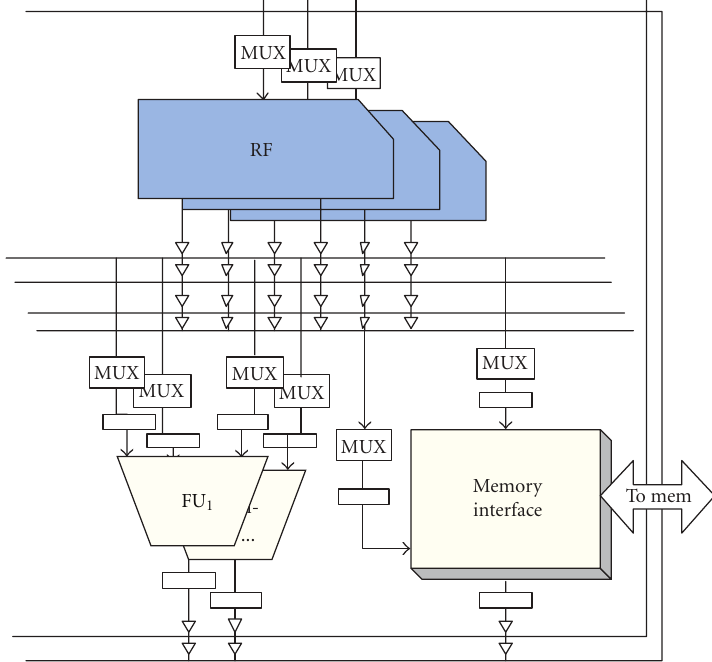
Figure 7: Used data path